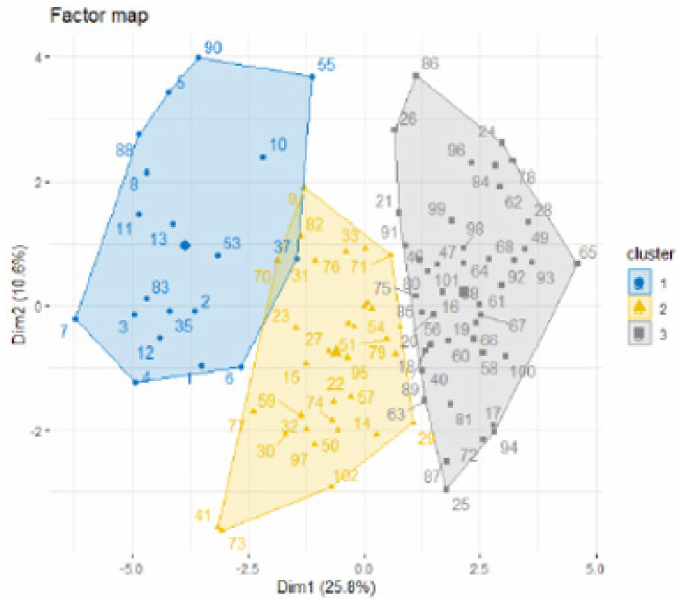
Figure 3. The individual factor map for the SCOOHP scale with 23 items.